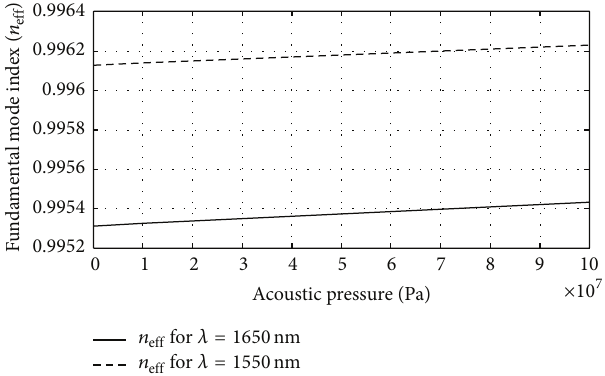
Figure 7: Fundamental mode index corresponding to wavelengths 1550 nm and 1650 nm as a function of the acoustic pressure at acoustic frequency 10 kHz.